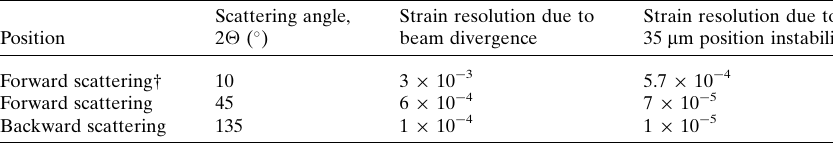
Table 1 Strain resolution in forward and backward scattering positions at important scattering angles for a detector at 300 mm from the